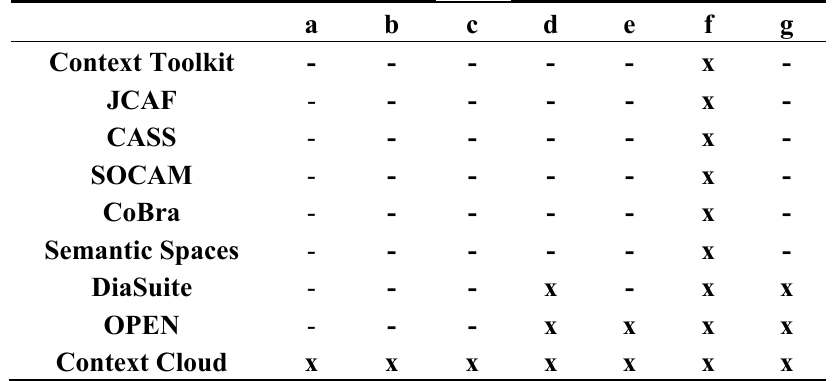
Table 1. Comparison of context-aware development